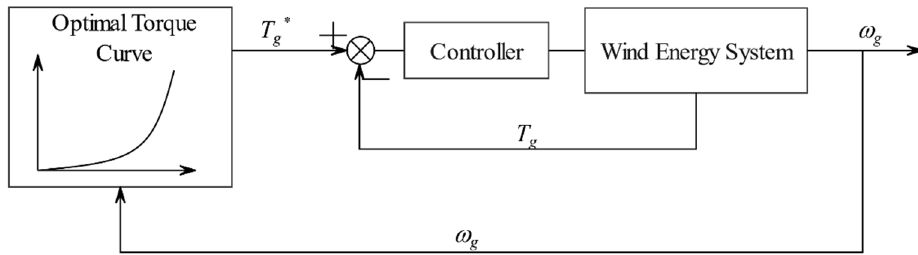
Figure 3. Block diagram of OT control principle. The “Optimal Torque Curve” is fitted by the experimental data of wind turbine manufacturers, and it will change with the environmental factors. The PI controller used in the “Controller” module adjusts the rotor speed of the wind turbine according to the error between T g and T g ∗ . “Wind Energy System” includes wind turbine model and electrical system [21] .